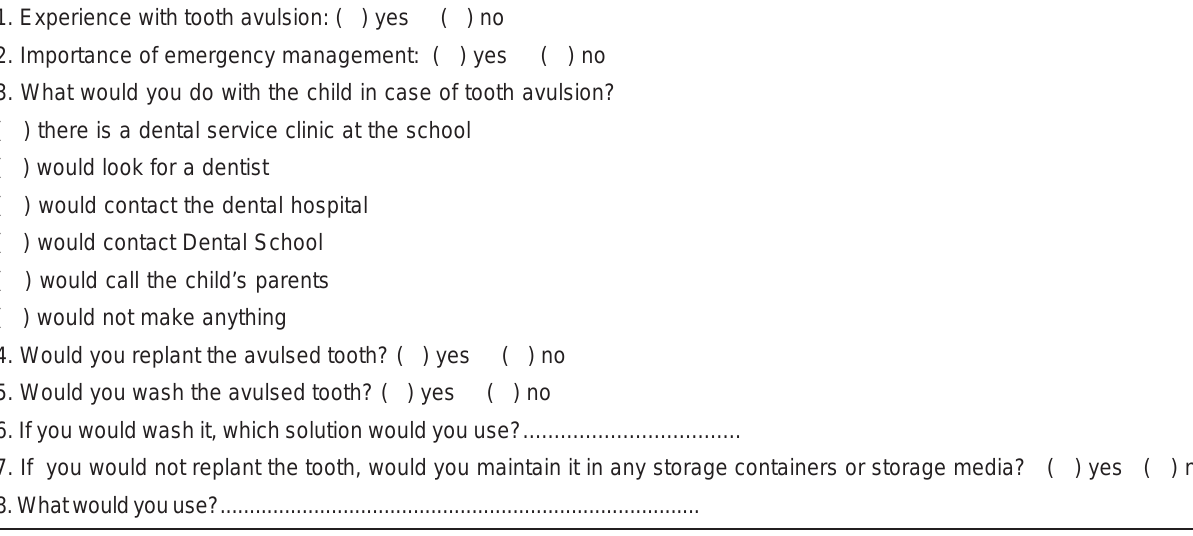
FIGURE 2- Questions in Part II of the questionnaire submitted to the professionals